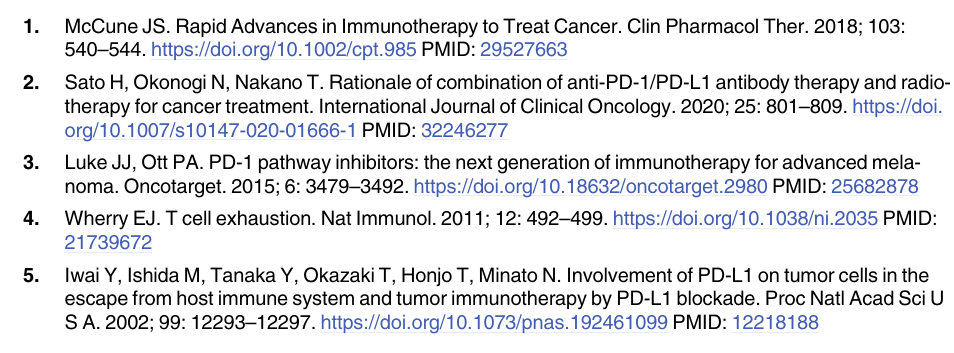
S5 Fig. Tumor volume change of individual mouse in the four groups. (a) Tumor growth curve are exhibited in green (NoTx) and red (P1only). S6 Fig. Tumor volume change of individual mouse in the groups. (a and d) The larger tumor growth (a) and the other (e) of the two in P1only group are exhibited individually. (b, c, d, e, f, g, and h) The tumor growth in IR tumor (solid line) (b, c, and d) and unIR tumor (dashed line) (f, g, and h) are exhibited in yellow (Rad only), blue (P1+pre-Rad), and gray (P1